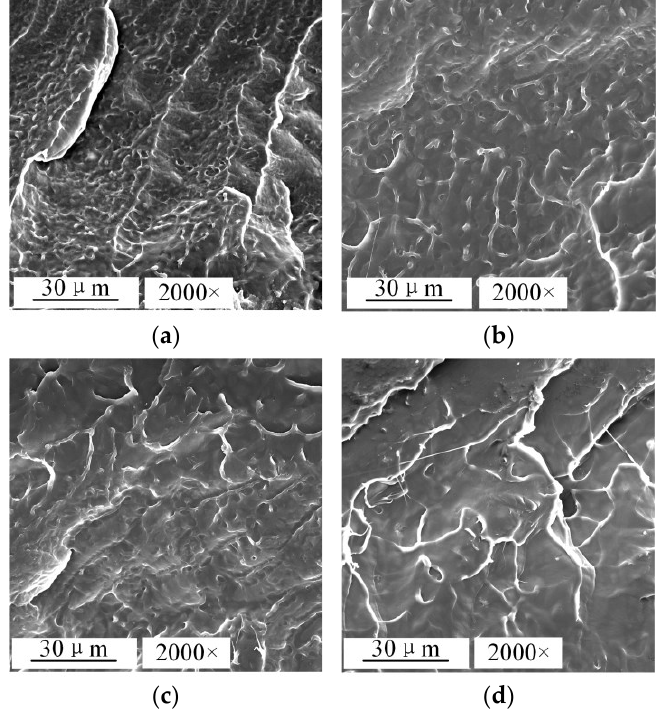
Figure 2. Micro-structure of the insulation layer under different aging time. ( a ) The unaged insulation layer; ( b ) the insulation layer aged for 168 h; ( c ) the insulation layer aged for 720 h; ( d ) the insulation layer aged for 1440 h.